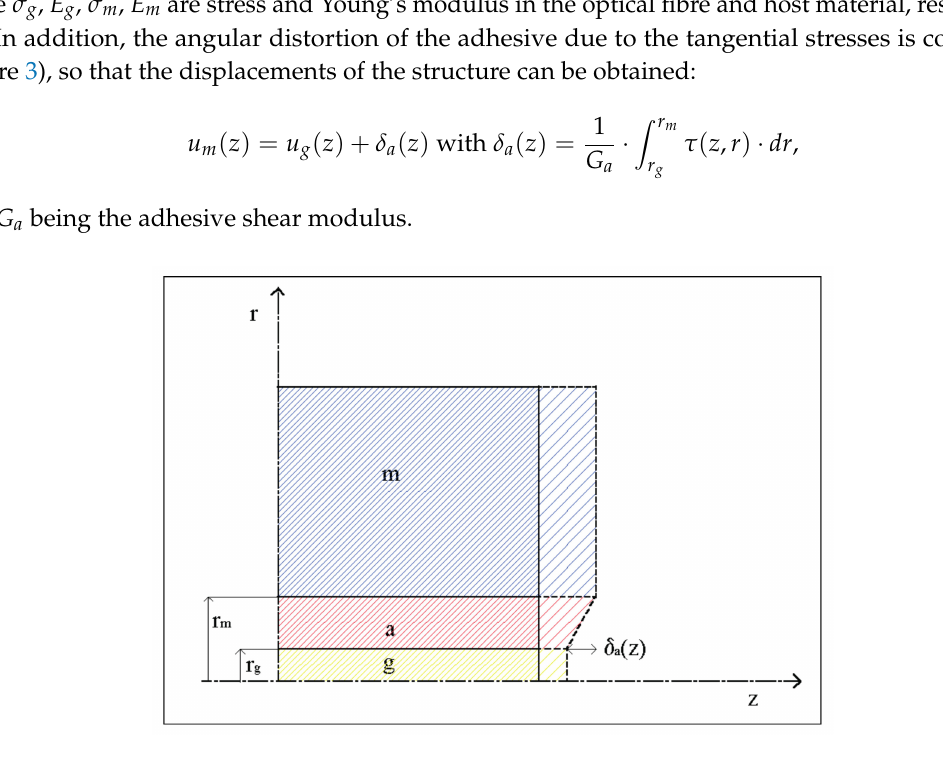
Figure 3. Angular distortion of the adhesive due to the tangential